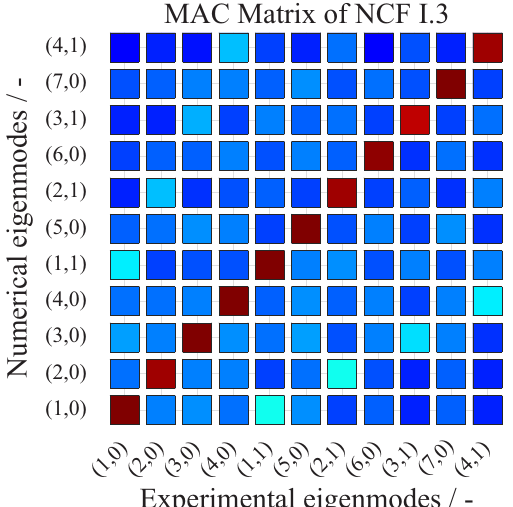
Figure 12. Comparison of measured and calculated mode shapes using the MAC for the NCF rotor